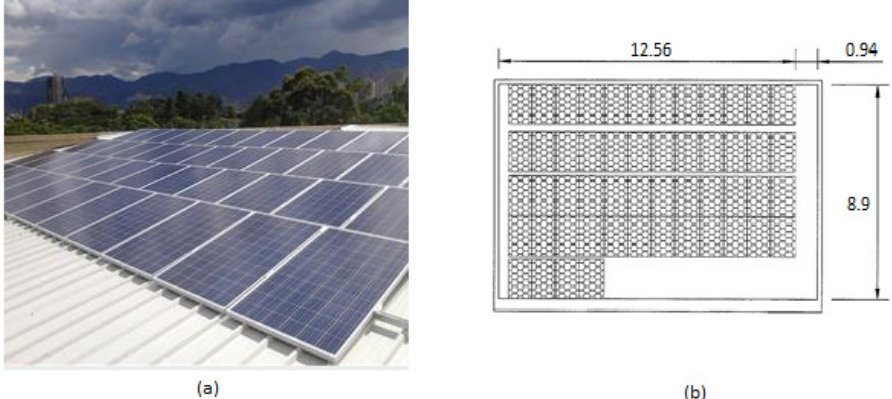
Figure 5. Photovoltaic (PV) plant located in Institución Universitaria Pascual Bravo at Medellin, Colombia: a picture of the PV panels ( a ); and the panel array on the library rooftop ( b ), with dimensions in